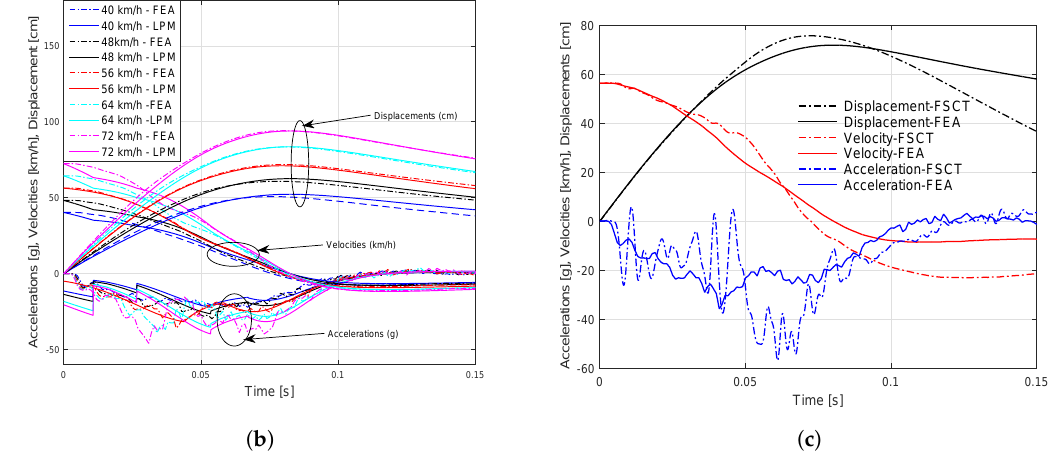
Figure 9. A summary of kinematic time histories for ( a ) LPM calibrated to FSCT; ( b ) LPM calibrated to FEM; ( c ) comparison between FEA and FSCT at 56 km/h.